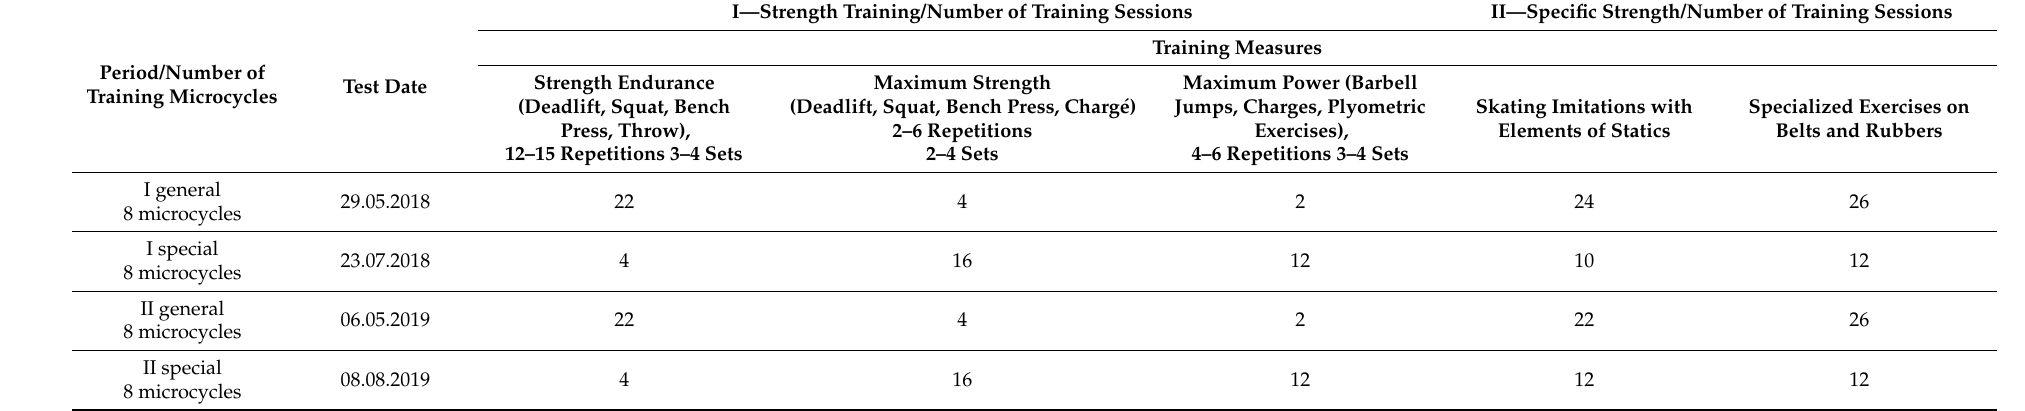
Table 4. Strength training in particular training